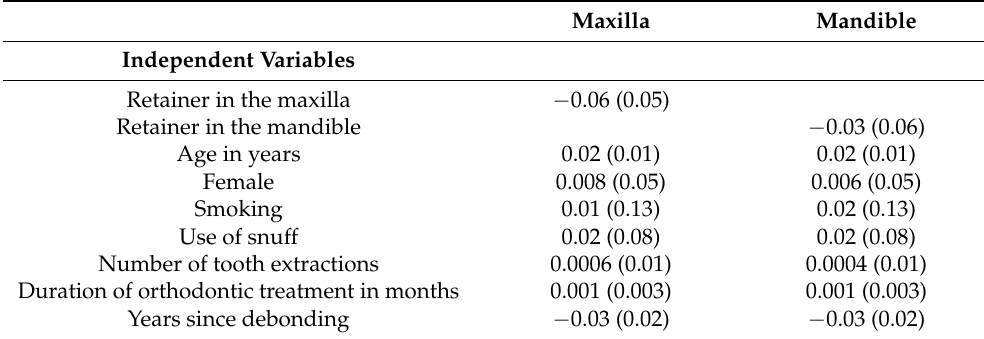
Table 4. Predictors of patient-reported dental sensitivity.